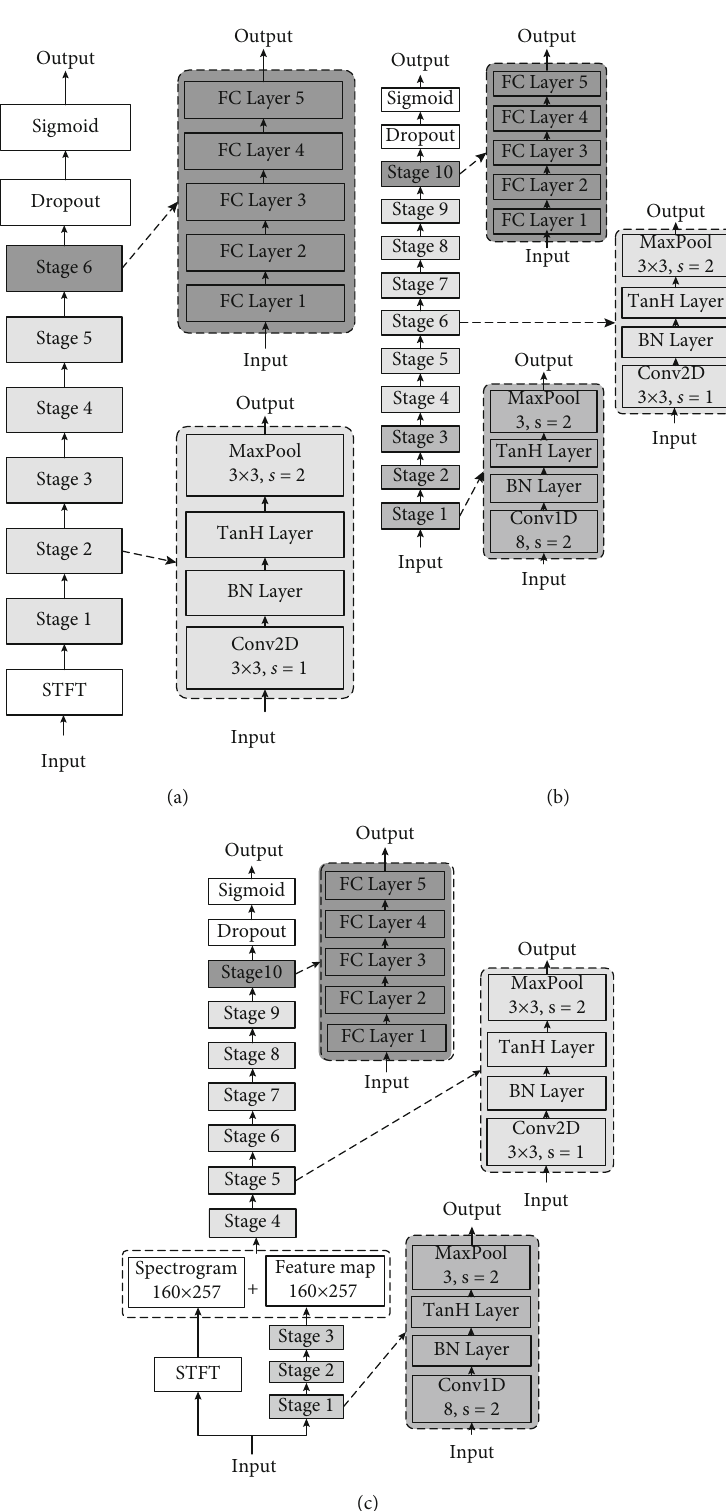
Figure 3: An overview of architectures of TFCNN (a), Mixed-CNN (b), and TF-HybridNet